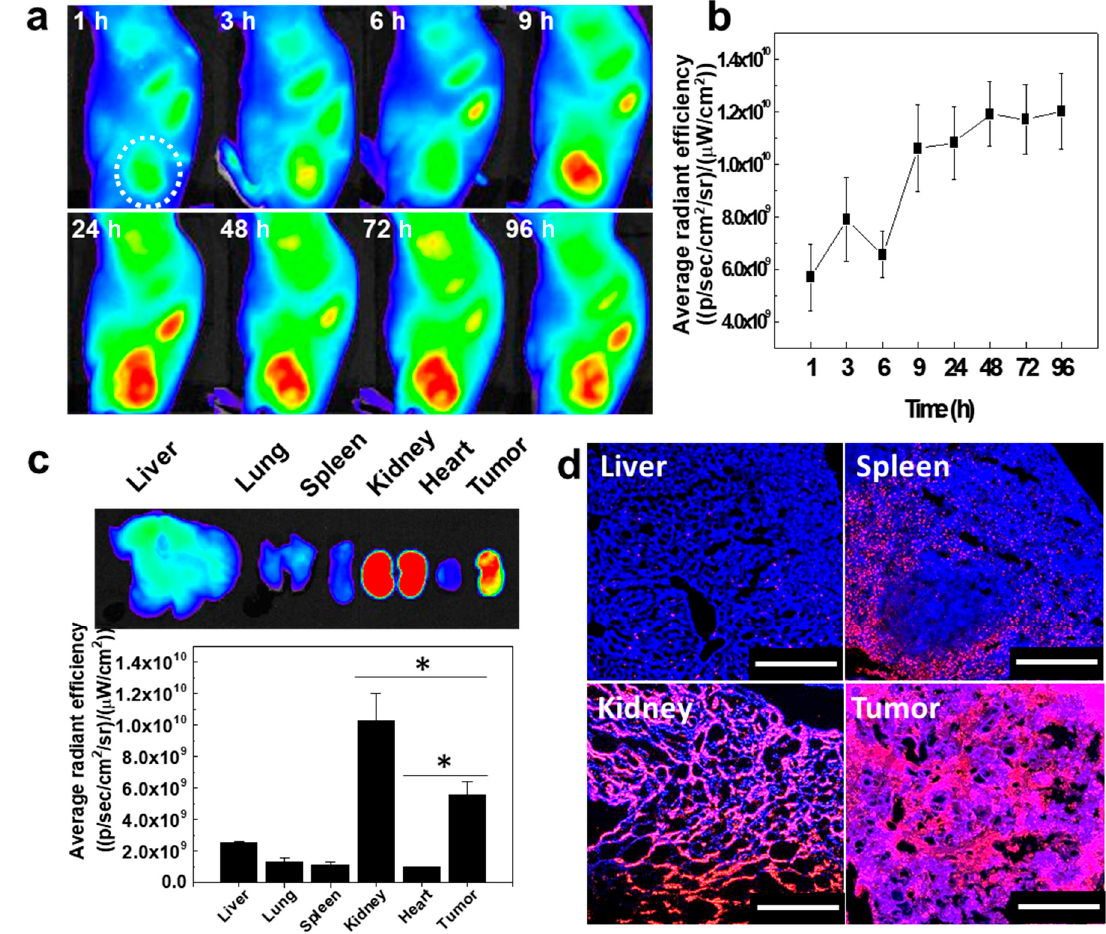
Figure 4. In vivo biodistribution of Cy5.5-CNPs in the VX2 tumor-bearing mouse ( n = 3). a ) Whole-body NIRF images of Cy5.5-CNPs. White dotted circle indicates tumor tissue. b ) Quantified NIRF signals of Cy5.5-CNPs over time. c ) Ex vivo NIRF images and quantified NIRF signals from tumor tissue and organs. (*) indicates difference at the p < 0.01 significance level. d ) Tissue fluorescence images of liver, spleen, kidney, and tumor. Blue channel = DAPI, red channel = Cy5.5-CNPs. The scale bar indicates 250 μ m.